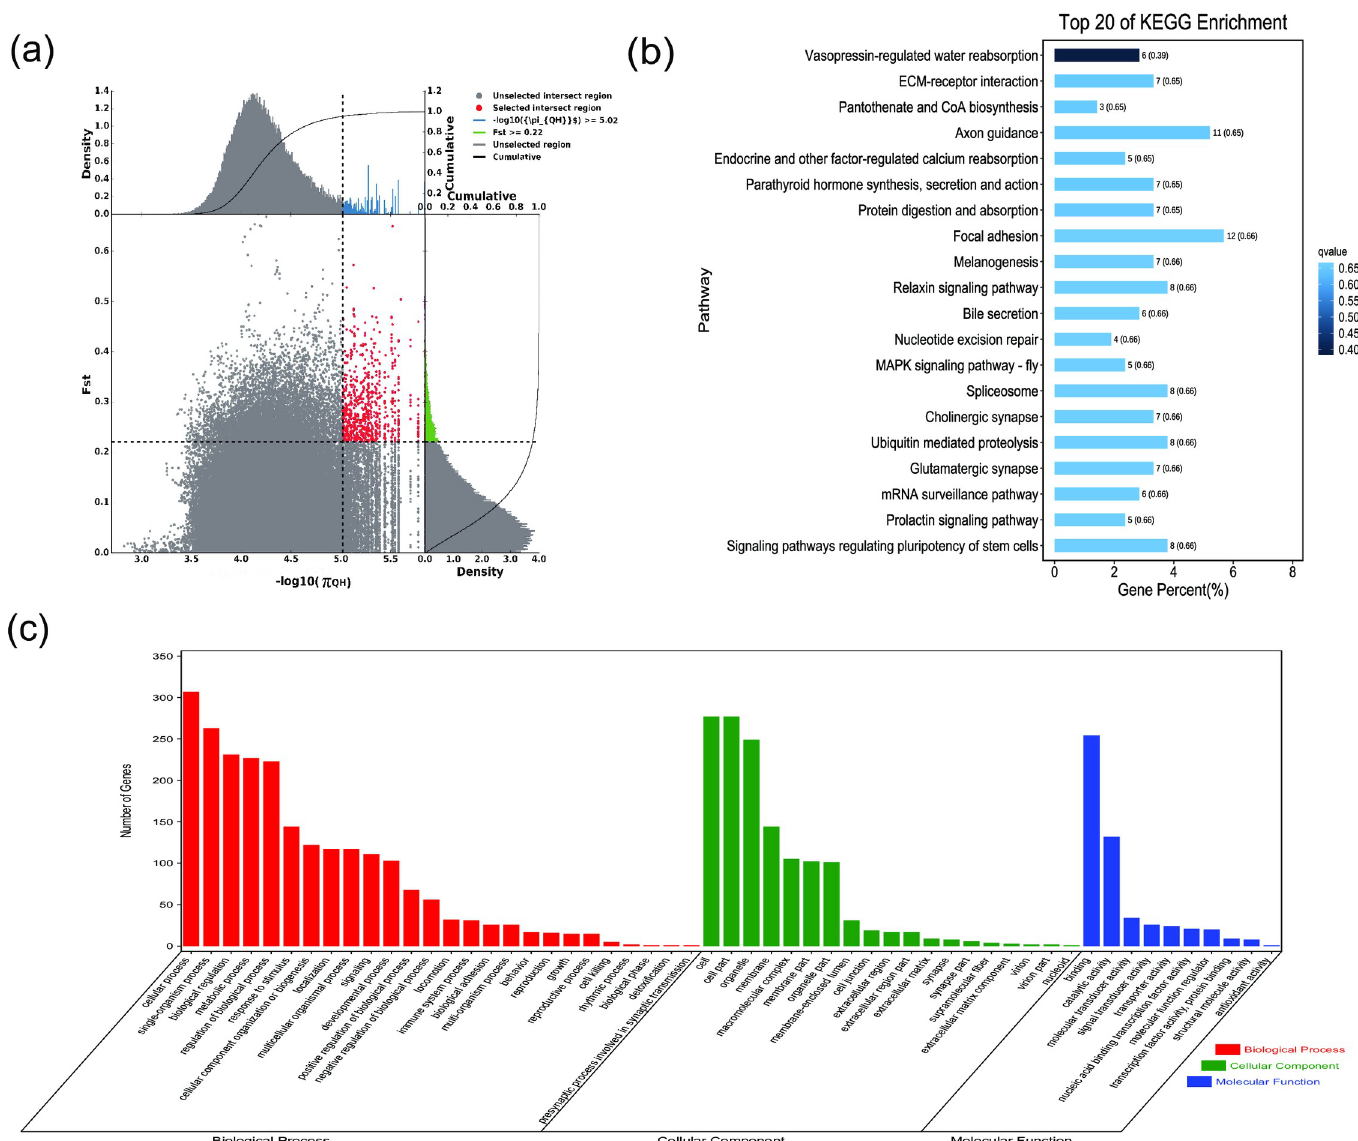
Fig 7. GO classification and KEGG enrichment of the selected genes of Qinghai camels. (a) With the pool of all remaining others as the reference population and Qinghai camels as the target population, 588 selected genes were obtained. (b) KEGG enrichment of 588 selected genes of Qinghai camels. (c) GO classification of 588 selected genes of Qinghai